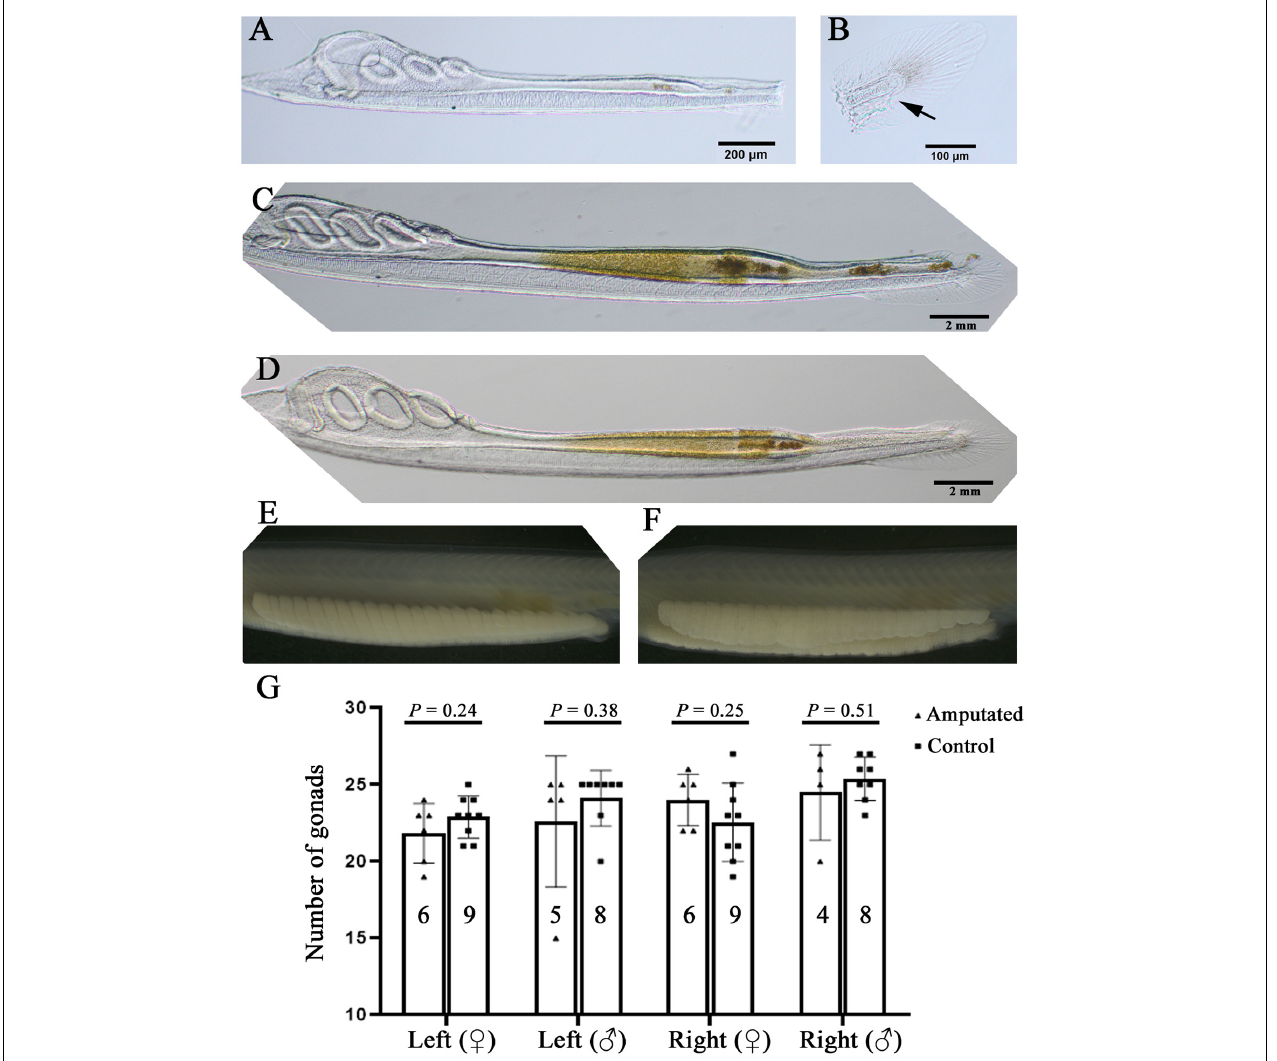
FIGURE 4 | Amphioxus larvae that have undergone posterior end amputation are able to regenerate and develop a normal number of gonads. (A) A representative larva just after posterior end amputation. (B) An example of the amputated posterior end. Arrow marks the anus. (C) An example of larva 3 days after posterior end amputation. Note that its posterior end was almost regenerated. (D) A larva with fully recovered posterior end 6 days after amputation. Left-side gonads of a male (E) and a female (F) whose posterior end was amputated at the larval stage. (G) Statistical analysis of gonad number in amputated and wild type (control) animals. Males and females, and their left-side and right-side gonads are compared separately. Animal numbers examined are shown in the columns. P -values calculated using a two-tailed unpaired t -test are shown above the